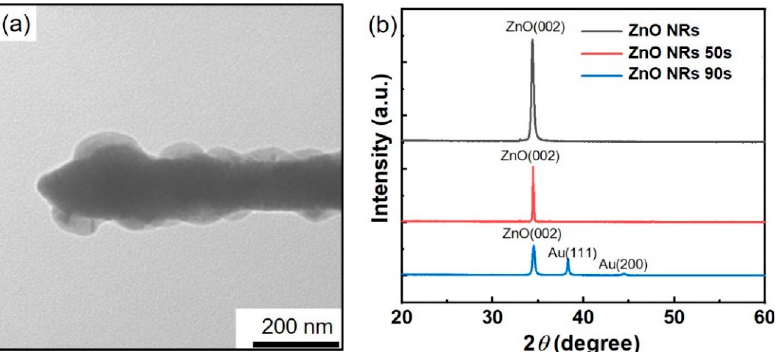
Figure 3. ( a ) TEM image of Au nanoparticles modified with single ZnO nanorod and ( b ) XRD patterns of ZnO NRs with different Au sputtering